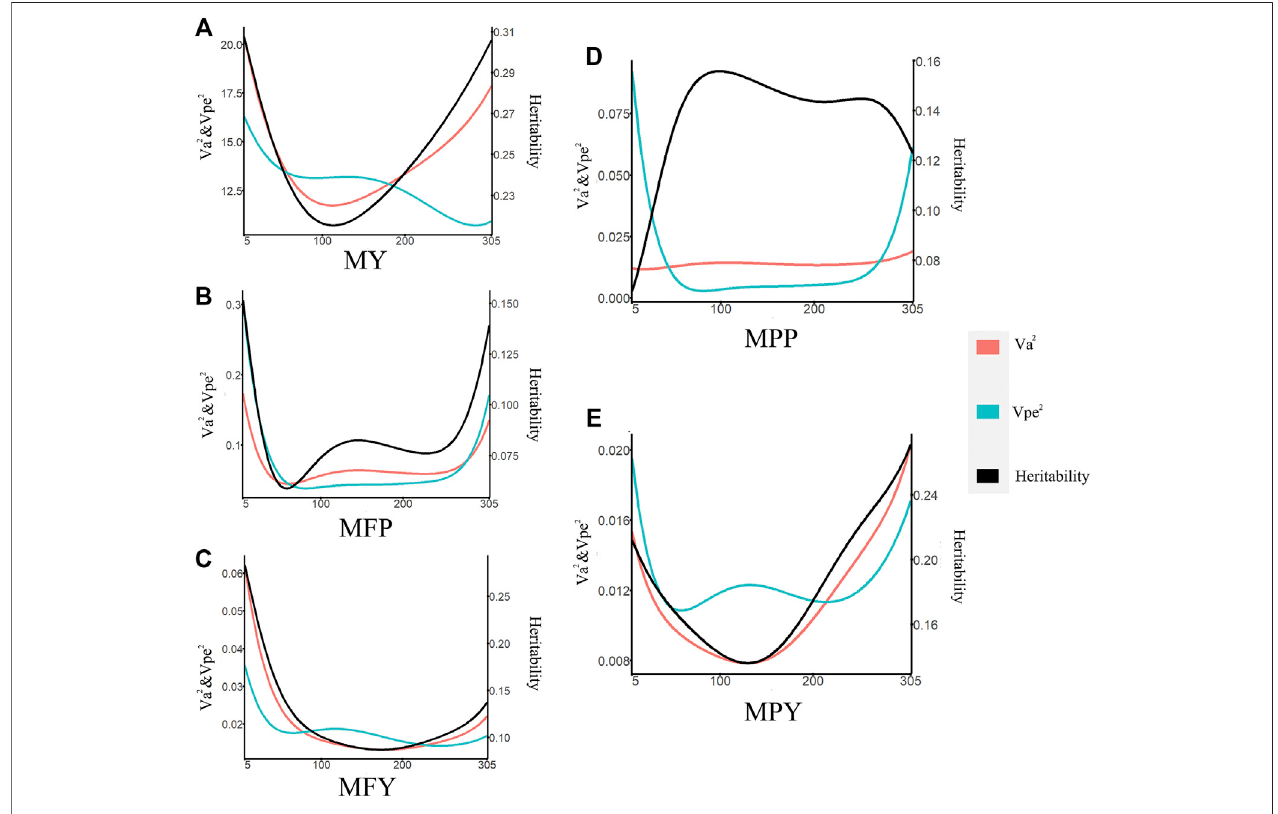
FIGURE 1 | Variance component estimates of milk-related traits during the lactation (red line, additive genetic variance; blue line, permanent environmental variance; black line, heritability; (A) MY, milk yield; (B) MFP, milk fat percentage; (C) MFY, milk fat yield; (D) MPP, milk protein percentage; (E) MPY, milk protein yield).